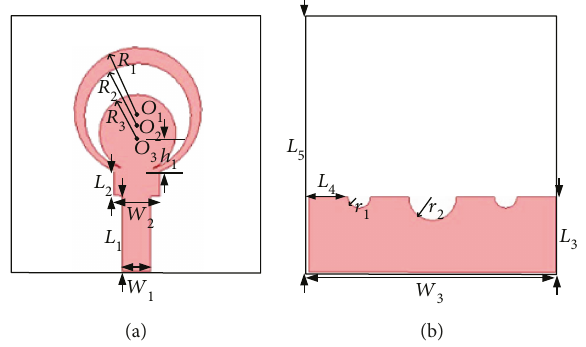
Figure 1: Geometry and parameters of a single element. (a) Front view. (b) Back view. Dimensions (unit: mm): W =3.0, L =8.0, 1 1 =4.9, L =2.7, h =4.0, R =6.8, R =5.7, R =4.1, W =28.5, W 2 2 1 1 2 3 3 L